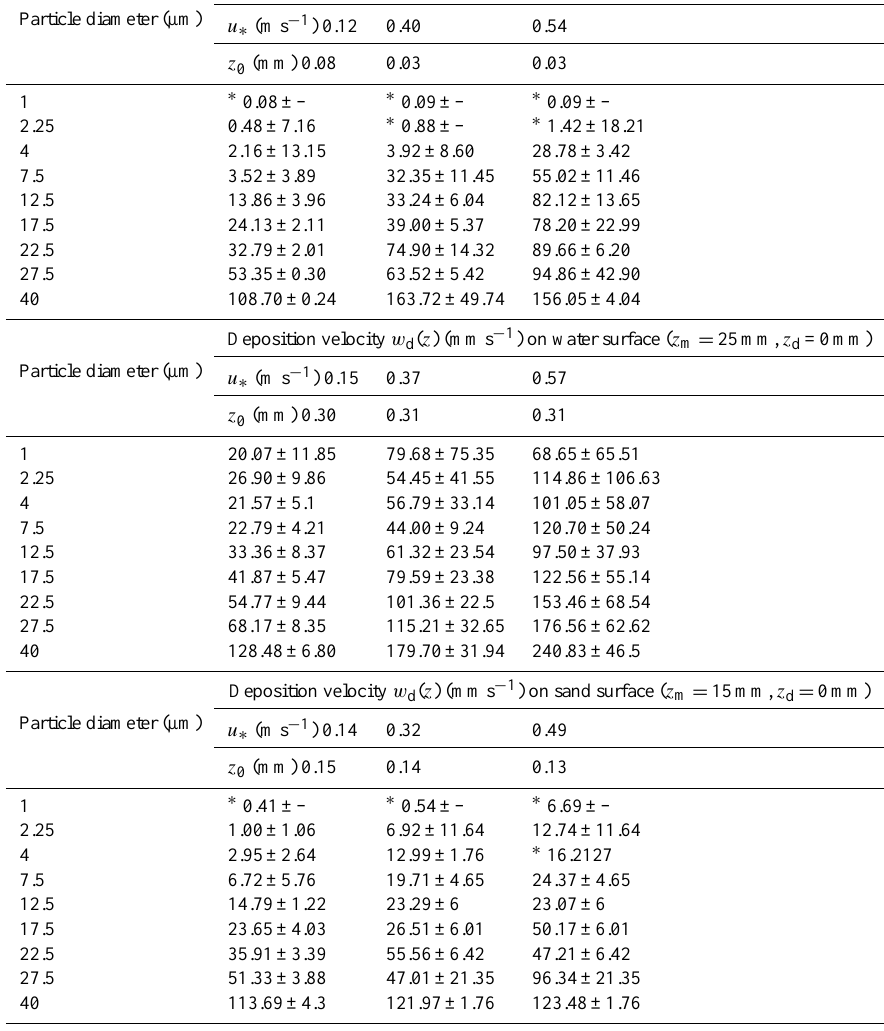
Table B2. Dust deposition velocity for different particle sizes, wind speeds and surface